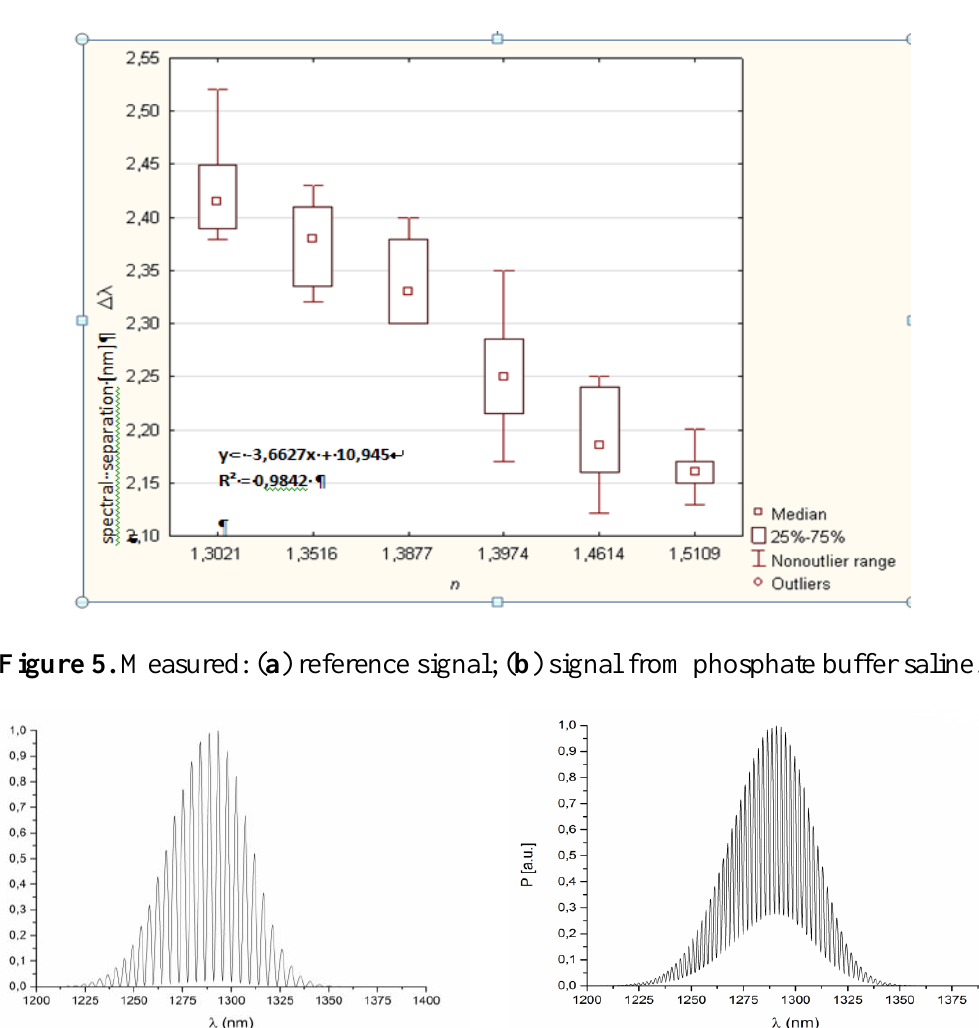
Figure 4. Spectral separation in the spectra of the measured signal vs. refractive index.